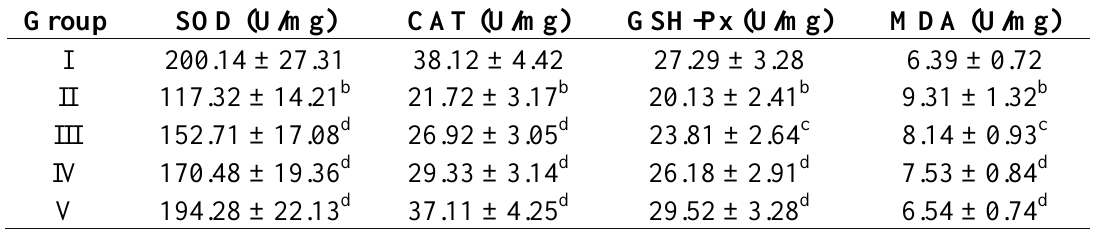
Table 3. Effect of Lycopene treatment on gastric SOD, CAT, GSH-Px activities and MDA level in gastric cancer rats.